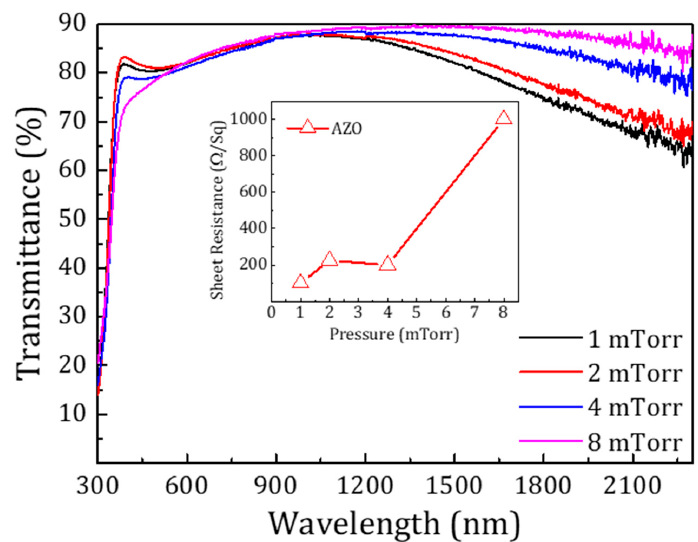
Figure 2. Optical transmittance of AZO films sputtered in Ar:H 2 atmosphere at varying pressure. Overall transmittance in the visible region was independent of the pressure. The inset shows the decrease in the sheet resistance of the films at lower pressures.